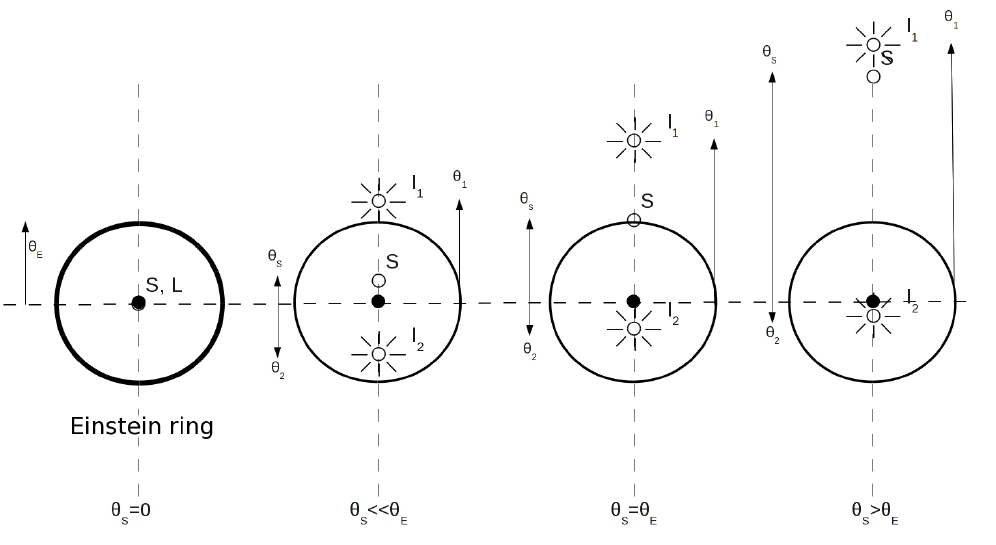
Figure 2. Angular positions of the primary ( I 1 ) and secondary ( I 2 ) images for four different values of the source impact parameter θ S in the case of a point-like